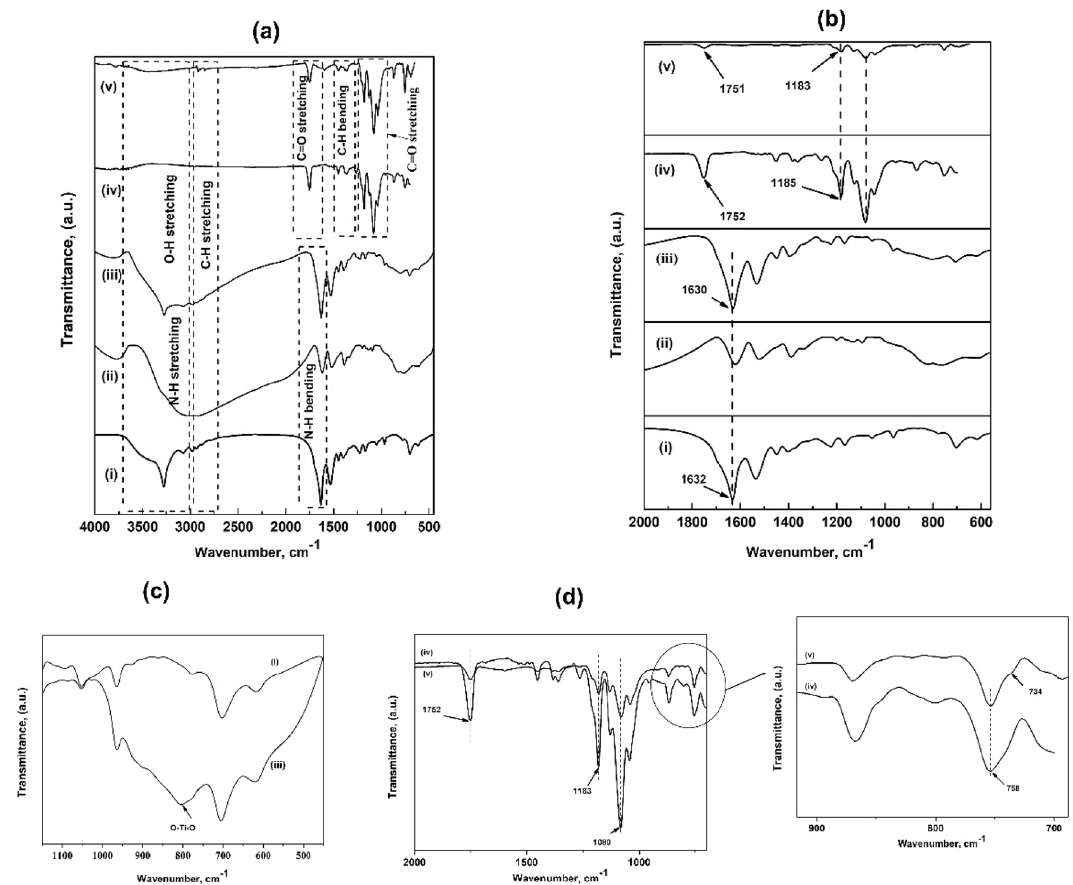
Figure 1. ( a ) FTIR spectra for (i) SNC; (ii) TCS; (iii) ana-TCS; (iv) PLLA (synthesized in lab for reference); (v) PLLA/ana-TCS, ( b ) Magnified FTIR spectra of the samples within the range of 2000–620 cm −1 , ( c ) Formation the presence of O–Ti–O